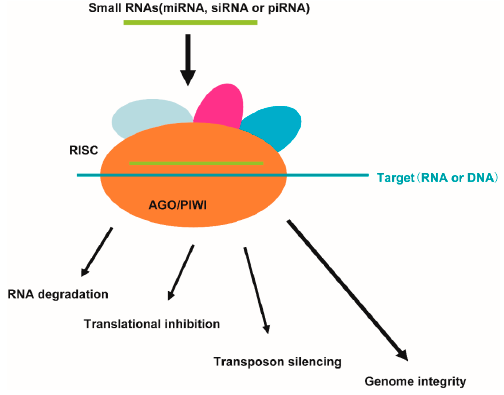
Figure 2. Guiding small RNAs’ gene silencing functions by AGO proteins.